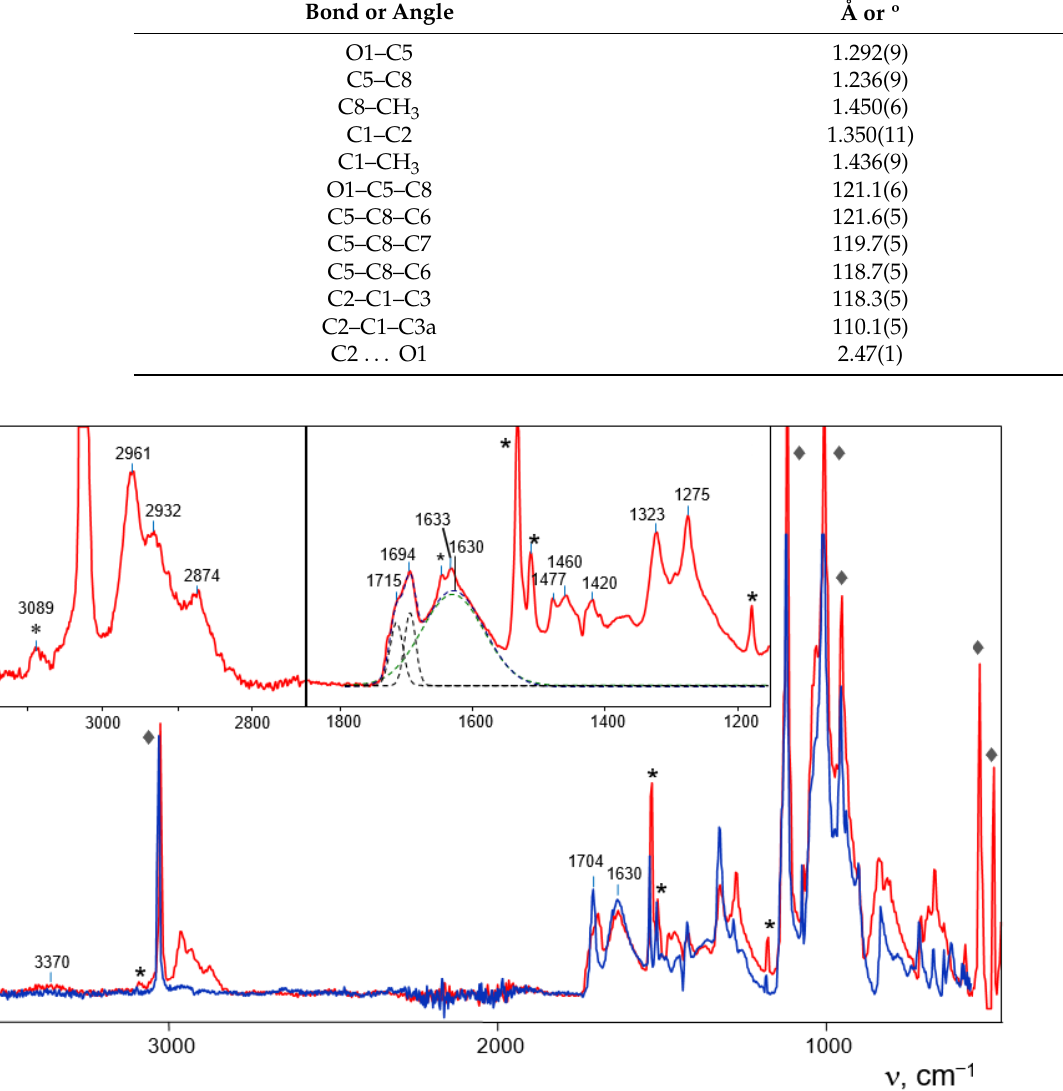
Table 3. Selected geometric parameter of cationic adduct II a according to X-ray data. Bond or Angle